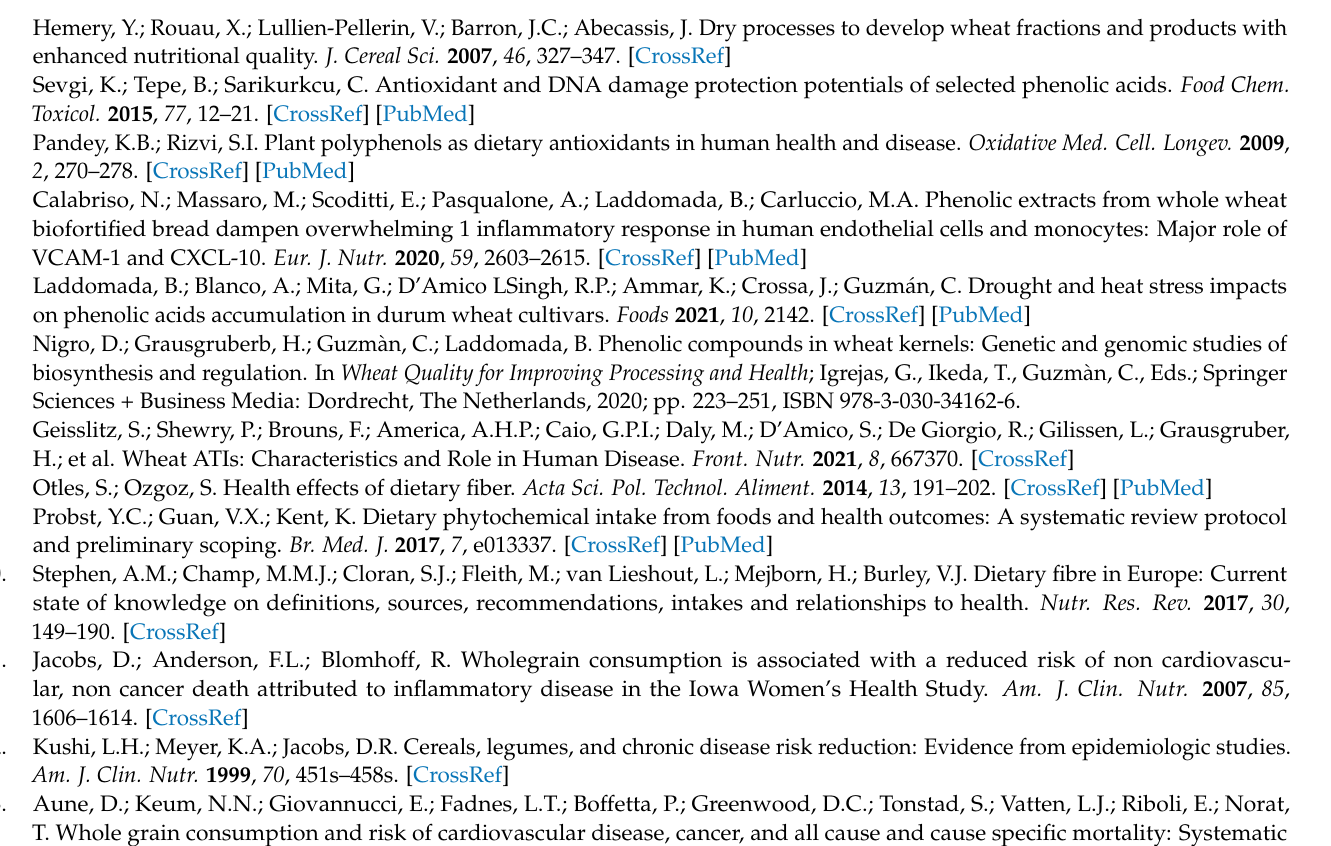
Table S2: Phe-nolic acid profiles ( µ g/g dry matter) and antioxidant activity ( µ eq Trolox/g dry matter) of cooked pasta made with air-classified fractions (F250, G250, G230) and semolina obtained from three durum grain samples (Saragolla_LA, Antalis_BA, Antalis_MA), Table S3: Anti-ATI polyclonal antibodies on micronized wholemeal, F250, G250, G230 air-classified fractions, and semolina from three durum grain